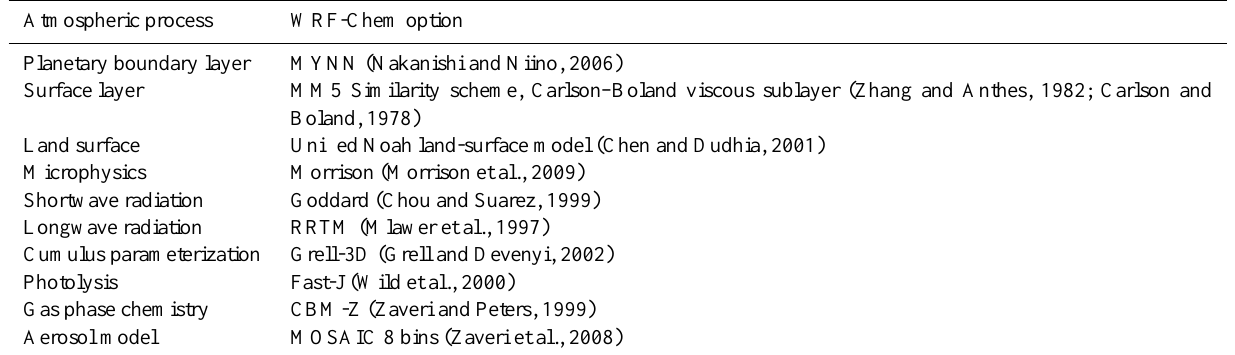
Figure 1. WRF and WRF-Chem domain (a) outer domains used for the MET, CTRL, and NOSHIP runs. ACCESS flight tracks during 11, 12, 19a (a – denotes that this was the first flight that occurred on this day, flight 19b – the second flight was dedicated to hydrocarbon extraction facilities) and 25 July 2012 flights are shown in color. (b) Inner domain used for the CTRL3 and NOSHIPS3 simulations, with the tracks of the four ships sampled during the 11 and 12 July 2012 flights (routes extracted from the STEAM2 inventory). Table 2. Parameterizations and options used for the WRF and WRF-Chem